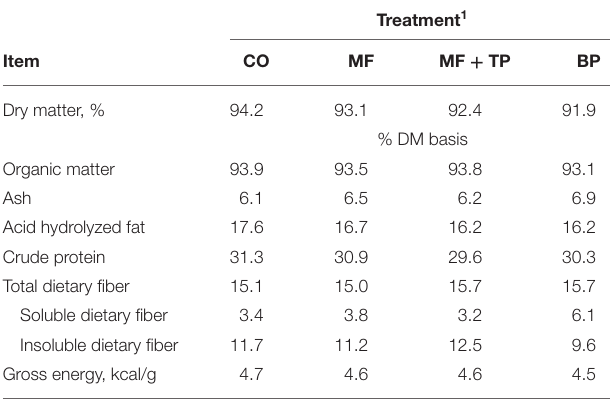
TABLE 2 | Chemical composition of treatments containing traditional and novel fiber sources for adult felines.